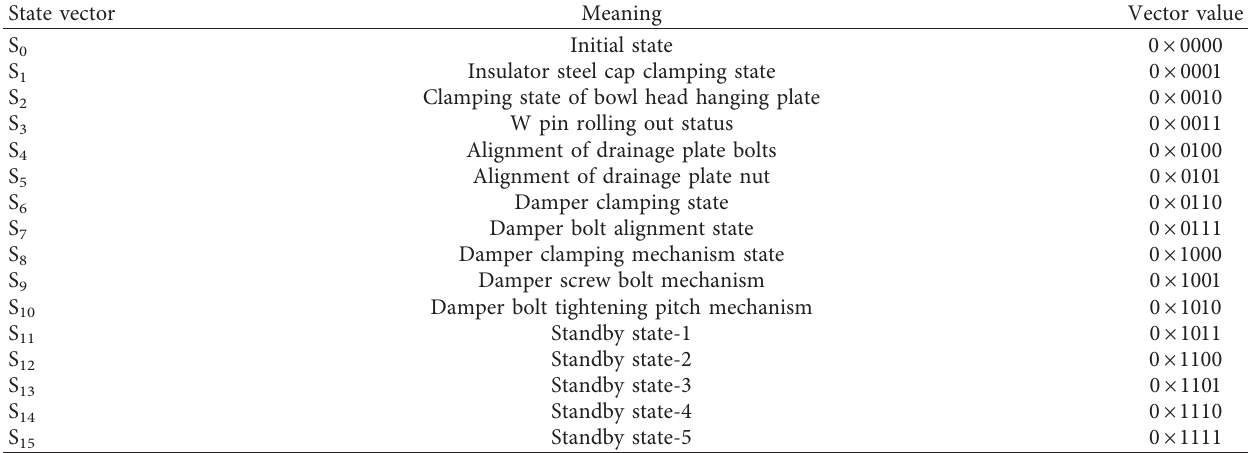
Table 5: The robot’s effective state vector